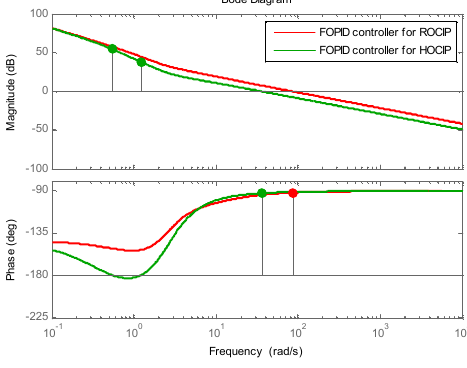
Figure 11. Bode plots of controlled ROCIP and HOCIP with an FOPID